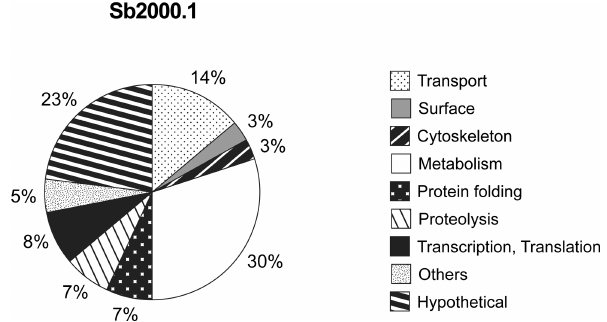
Figure 1. Functional assignment of proteins found differentially expressed by SILAC between L. infantum WT and Sb2000.1 mutant. Protein functional classification was based on GeneDB annotations and Gene